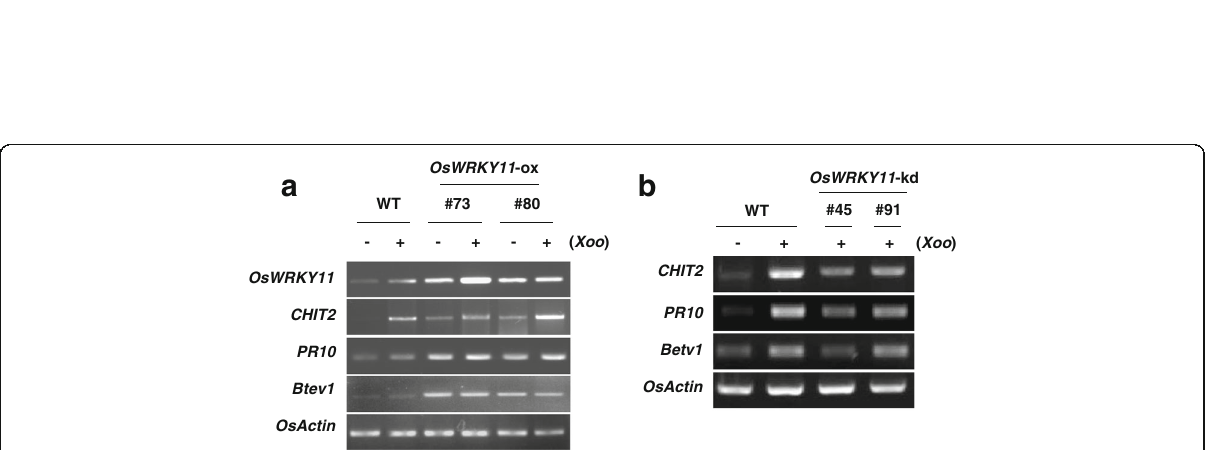
Fig. 3 Expression analysis of defense-related genes in OsWRKY11 -ox and OsWRKY11 -kd lines. a Total RNA was isolated from WT plants and OsWRKY11 -ox plants either infected with Xoo or non-infected. RT-PCR was performed using gene-specific primers for CHITINASE 2 ( CHIT2 ), PR10 , and Betv1 . b OsWRKY11 -kd plants were infected with Xoo using the toothpick inoculation method, and samples were collected at 24 hpi. Expression patterns of CHIT2 , PR10 , and Betv1 in OsWRKY11 -kd lines were analyzed using RT-PCR with gene-specific primers. Transcript levels of OsACTIN were used as internal controls. These experiments were repeated more than